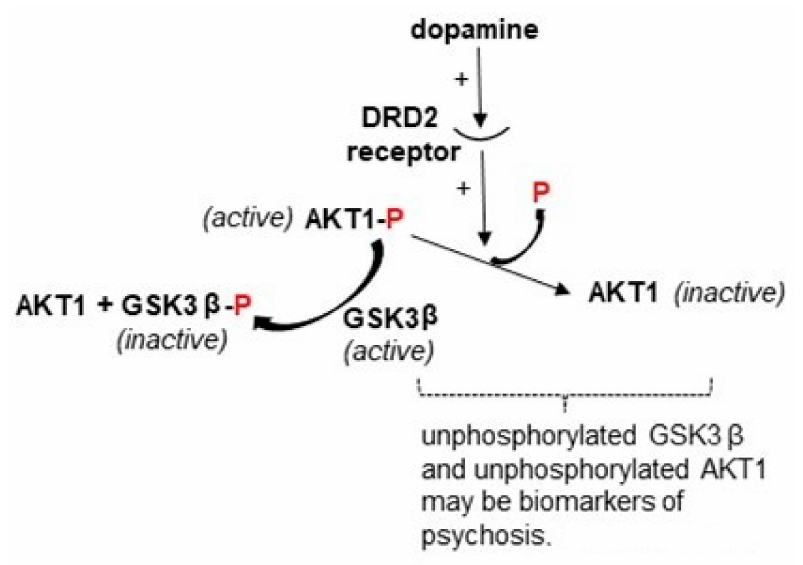
Figure 3. The dopamine signaling pathway that inactivates AKT1 and maintains activity of GSK3 β by preventing its phosphorylation by